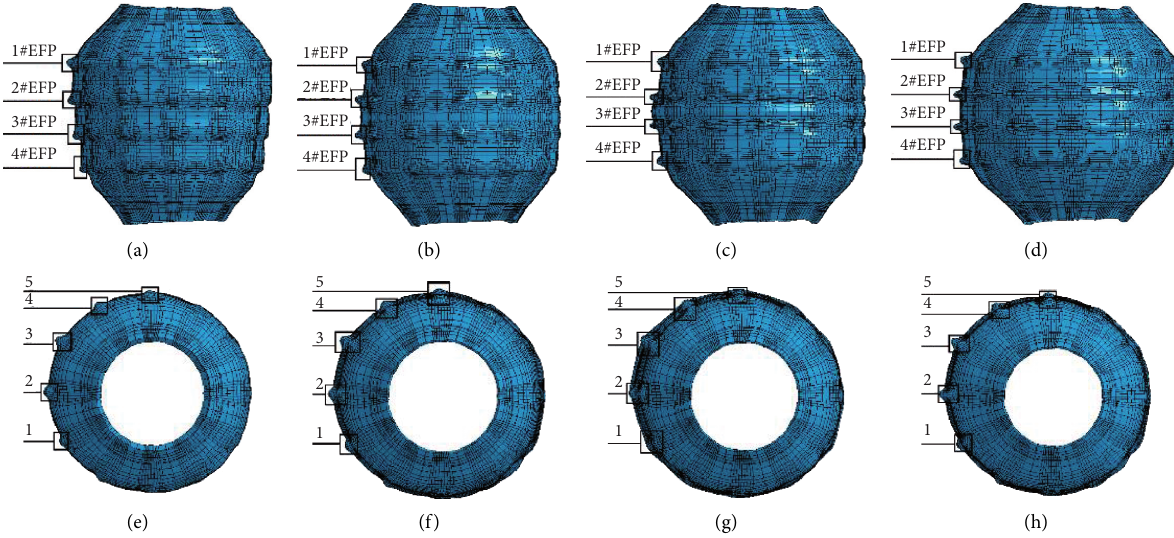
Figure 11: The forming result of double-column multipoints synchronous